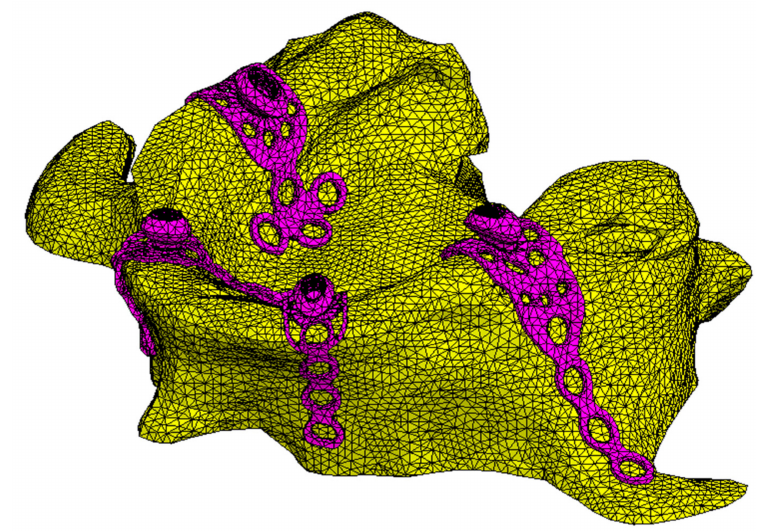
Figure 7. Finite element mesh (isometric view).